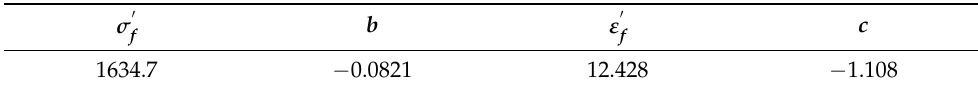
Table 1. Strain fatigue parameters of TC21 titanium